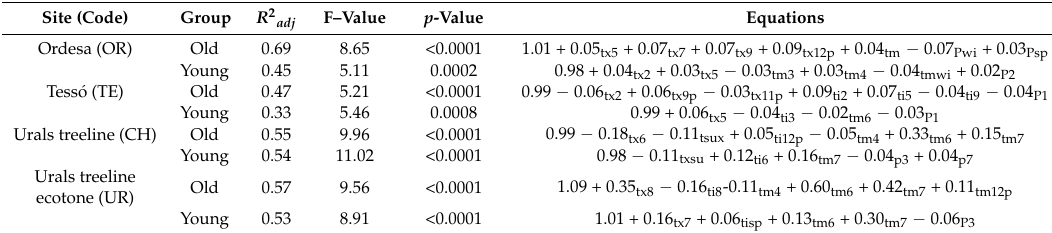
Table 4. Summary of the Generalized Least Squares Regressions (GLS) models used to forecast site chronologies of ring-width indices (TRWi). The percentage of variance explained by climate-based models is given by the adjusted coefficient of determination ( R 2 adj ). Abbreviations: p , precipitation; tm, mean temperature; tx, mean maximum temperature; ti, mean minimum temperature; sp, spring; su, summer. Numbers after climate variables indicate months, whereas the subscript “ p ” indicates the previous